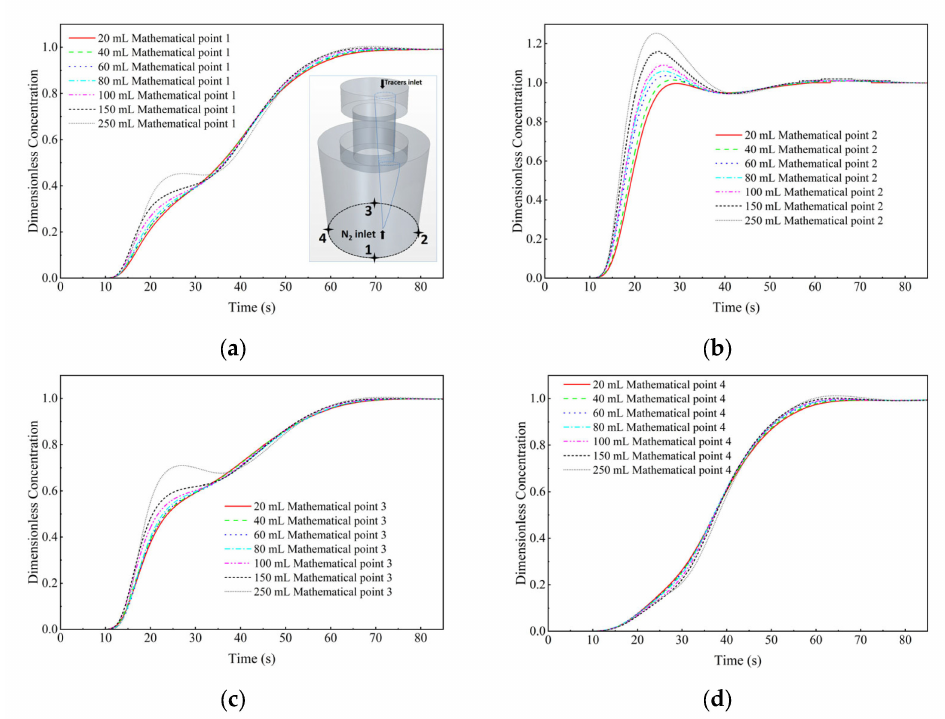
Figure 19. Comparison of the dimensionless concentration-time curves of the KCl solution cases with different dosages at different monitor locations. ( a ) Monitor point 1, ( b ) Monitor point 2, ( c ) Monitor point 3, and ( d ) Monitor point